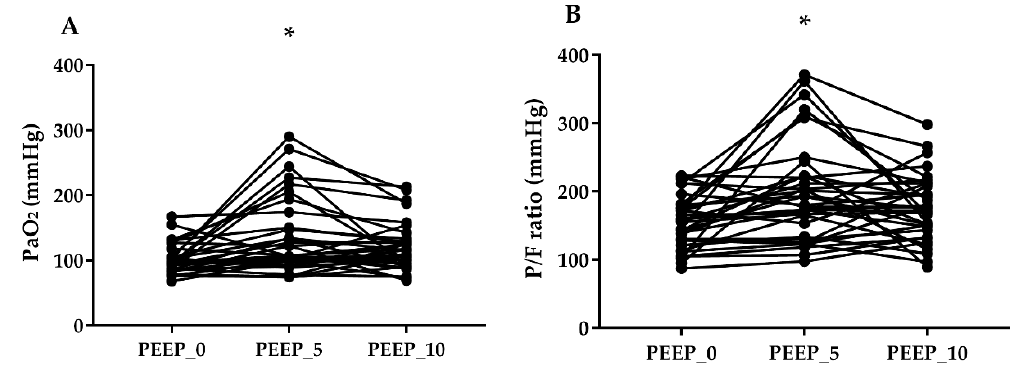
Figure 3. Effects of positive end-expiratory pressure on the changes of arterial oxygen partial pressure (PaO 2 , A ), the ratio of arterial oxygen partial pressure to inspired oxygen fraction (P/F ratio, B ). * p < 0.05 versus PEEP_0. Table 2. Arterial blood gas analysis and respiratory variables during two-lung ventilation (TLV) and